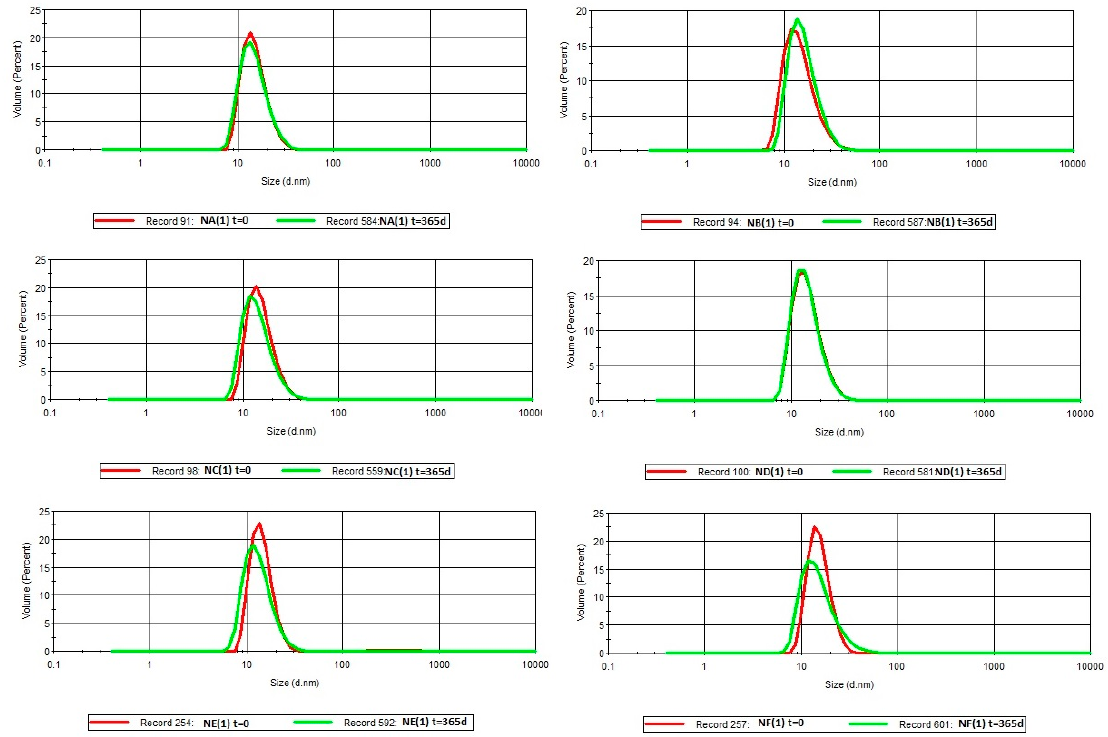
Figure 4. Droplet size distribution of the nanoemulsions on the basis of A–F fragrance composition, over time, for S:O = 0.625:0.375 ( t = 0 and t = 365